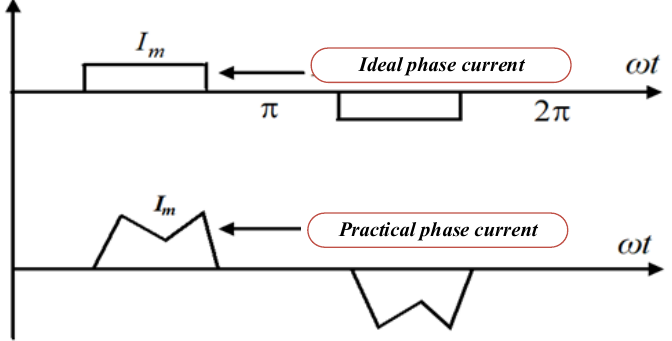
Figure 1. Waveforms of practical and ideal phase current.